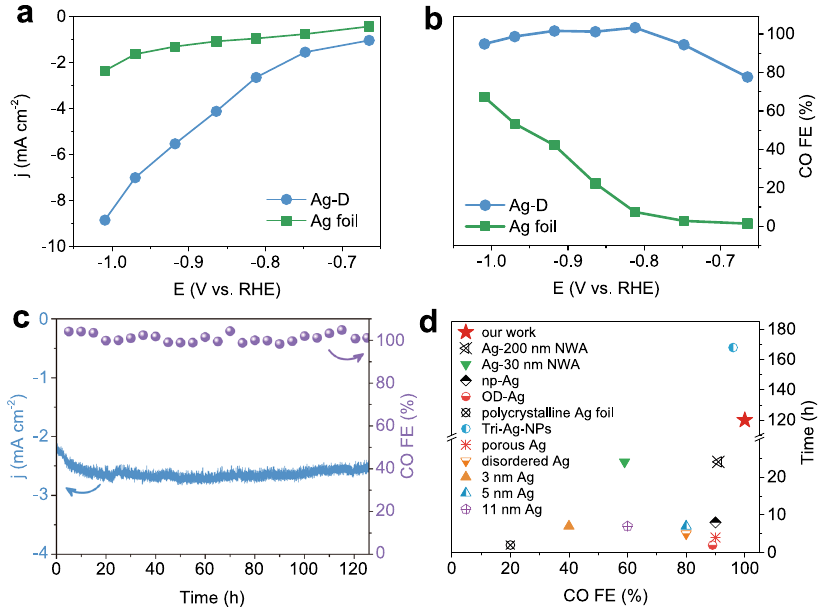
Fig. 3 Electrochemical measurements in an H-cell reactor. a Total current density (j) curves of Ag-D and Ag foil catalysts. b FE of CO for Ag-D and Ag foil. c Stability of the total current density and FE of CO for the Ag-D catalyst. d ECR performance comparison on stability and FE of CO for some representative Ag-based